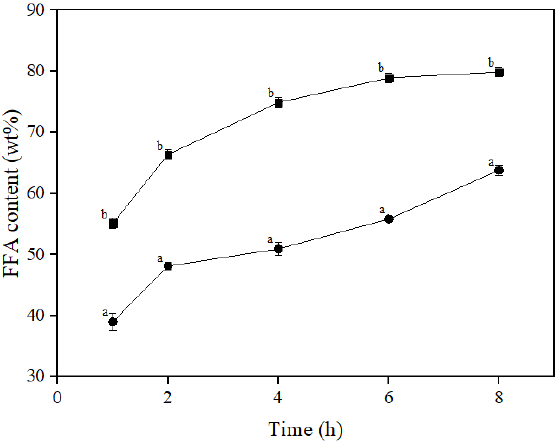
Figure 1. FFA content obtained in the reactions carried out at 55 °C, 5 wt% Lipozyme® RM IM, 50 wt% buffer solution, and stirring rate of 400 rpm with substrates pre-emulsion and without substrates pre-emulsion. Means followed by the same letter, for the same reaction time, do not statistically differ (p<0.05).